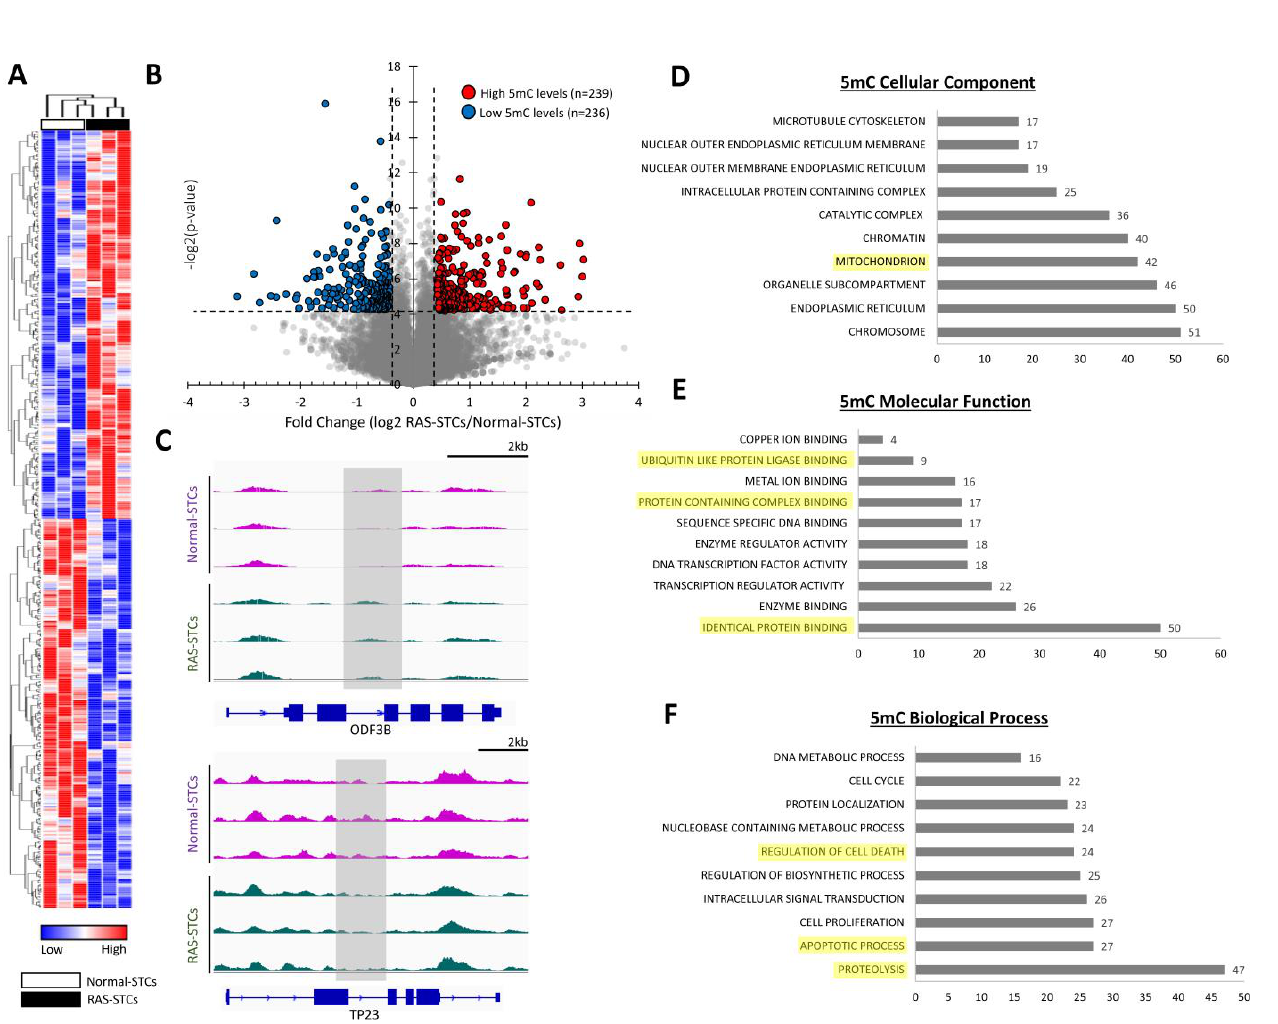
Figure 2. Renal artery stenosis (RAS) induces significant changes in 5-methylcytosine (5mC) levels in swine STCs. ( A ): Heat map of genes with significant changes in 5mC levels between Normal- and RAS-STCs. ( B ): Volcano plot of dysregulated 5mC genes. The vertical axis (y-axis) corresponds to the -log 2 ( p -value) and the horizontal axis (x-axis) displays the log 2-fold change (RAS-STCs/Normal-STCs) value. Genes with higher ( n = 239) and lower ( n = 236) 5mC levels in RAS- versus Normal-STCs are shown with red and blue dots, respectively, while non-significant genes are shown as grey dots. A p -value ≤0.05 and fold changes ≥1.4 or ≤0.7 are indicated by black dashed lines. ( C ): Representative reads for ODF3B and TP23 genes in Normal- and RAS-STCs were visualized using Integrative Genomics Viewer. Gray rectangles indicate regions (peaks) with higher and lower 5mC levels in RAS- versus Normal-STCs. D–F: Gene ontology (GO) analysis of cellular component ( D ), molecular function ( E ), and biological process ( F ) of genes with significant changes in 5mC levels between Normal- and RAS-STCs.